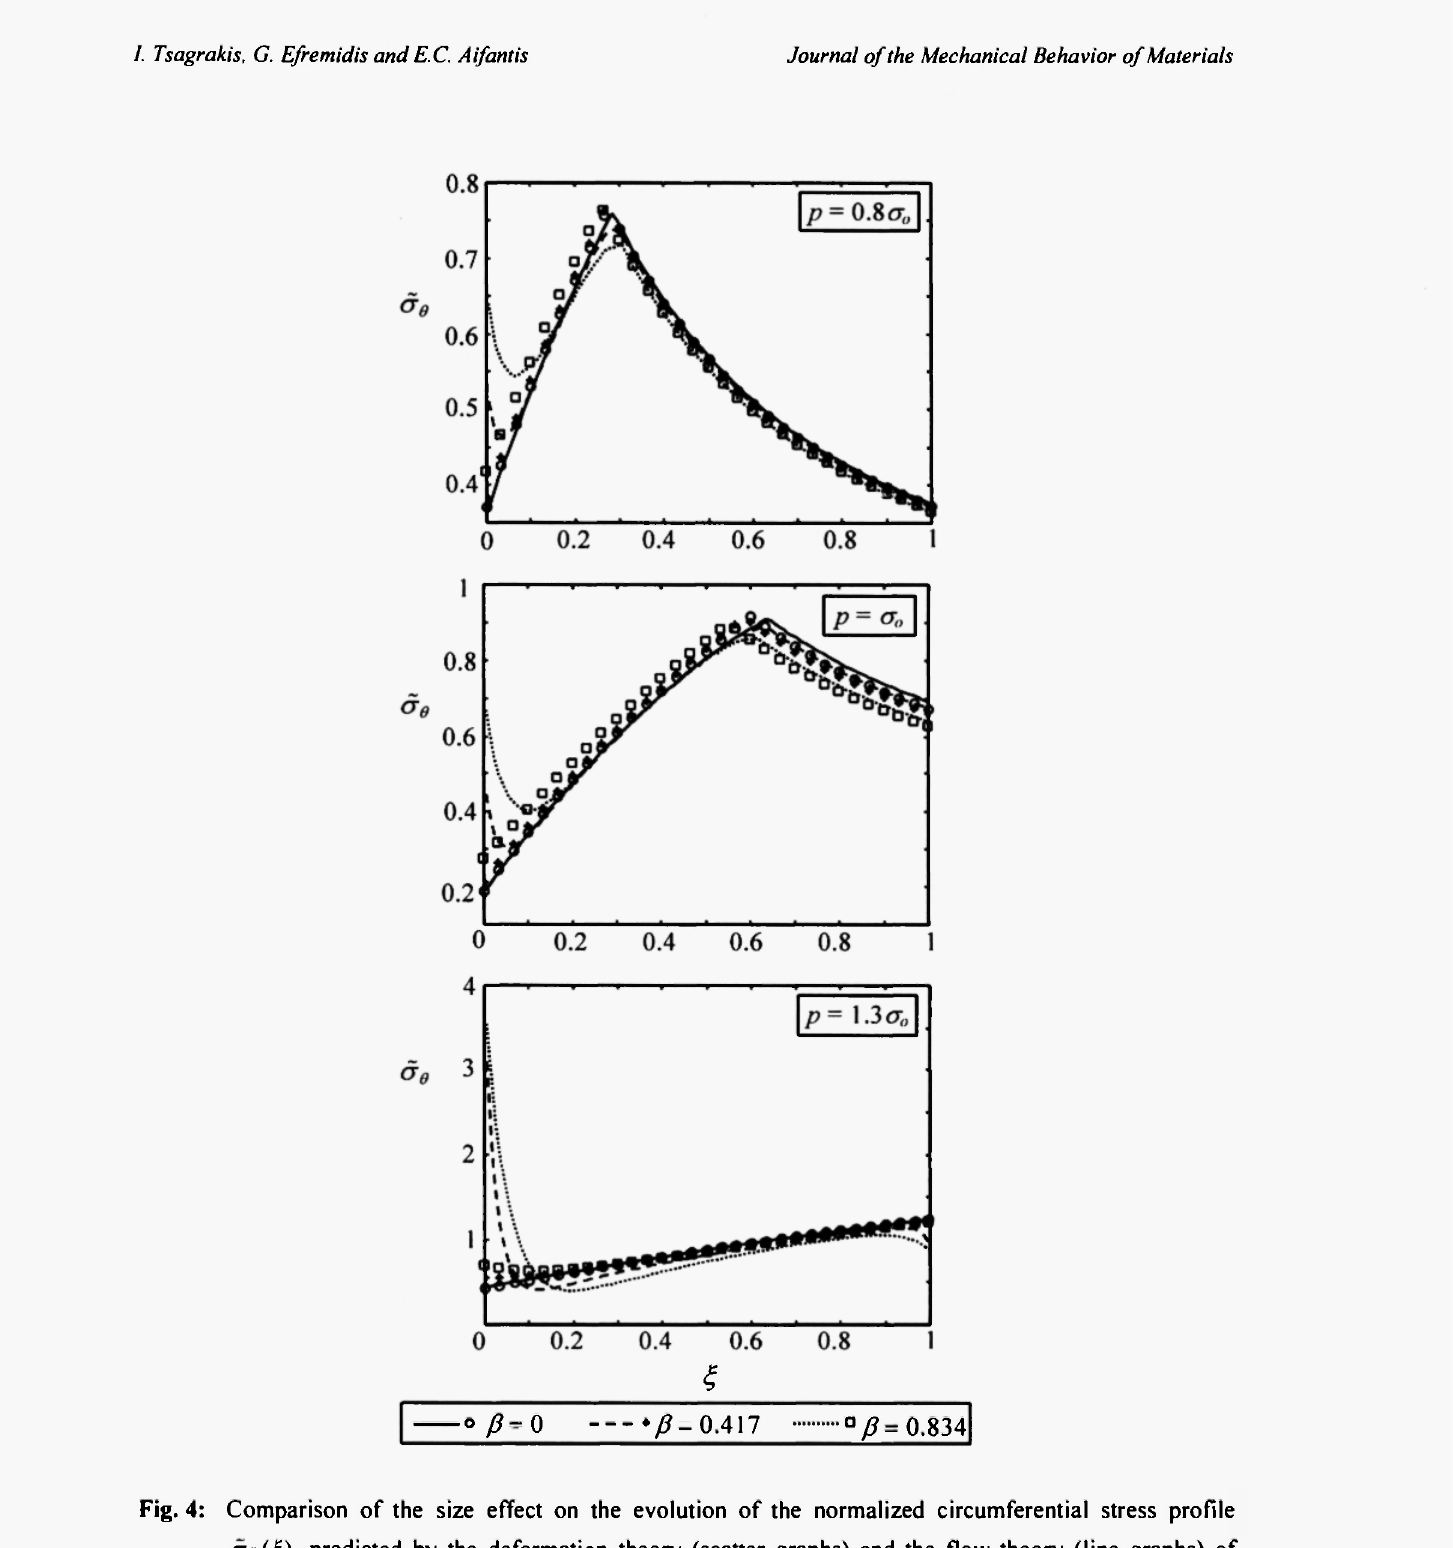
Fig. 4: Comparison of the size effect on the evolution of the normalized circumferential stress profile σο(ξ) predicted by the deformation theory (scatter graphs) and the flow theory (line graphs) of gradient